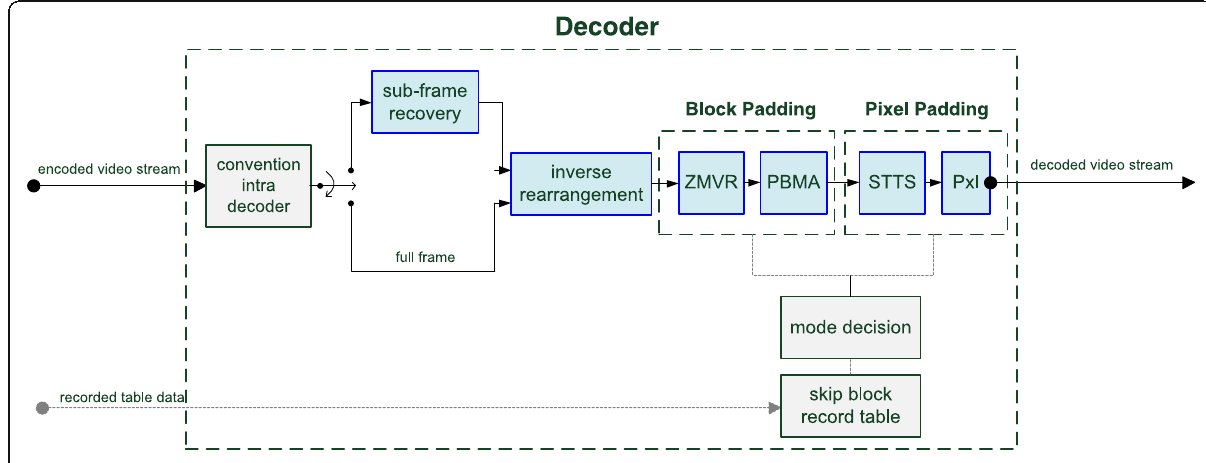
Fig. 7 The decoder architecture of PB-based